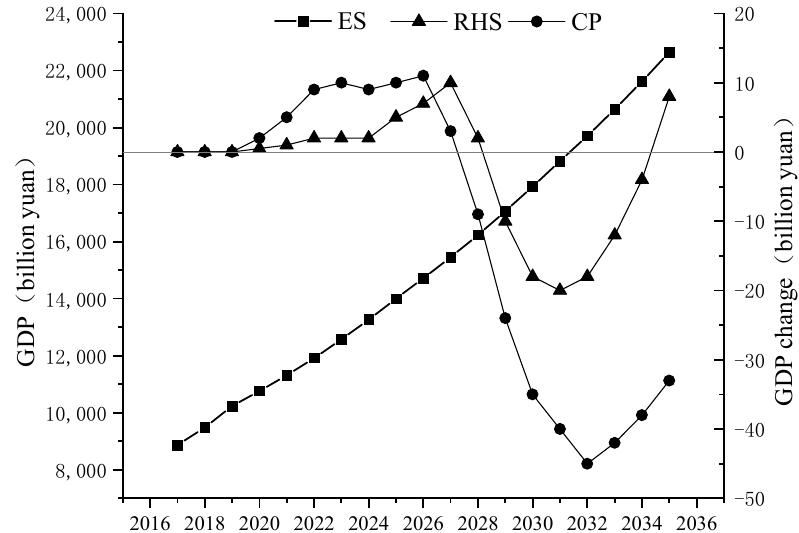
Figure 6. Change trend of GDP under ES scenario (left y-axis) and GDP change in RHS and CP scenario compared with ES scenario (right y-axis).